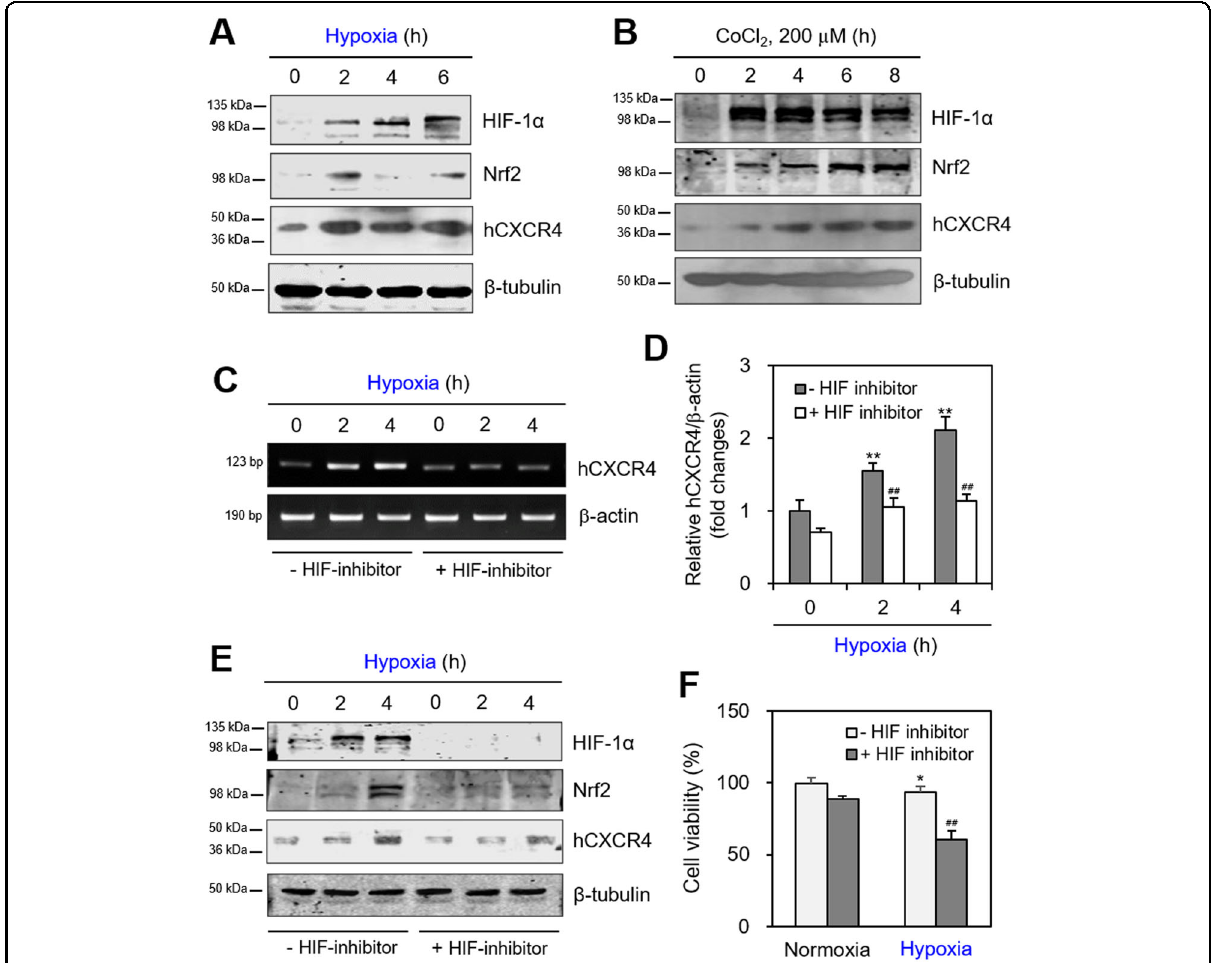
incubated in the presence or the absence of HIF inhibitor under hypoxic conditions. RNA was extracted by using Nucleozol. mRNA of hCXCR4 was measured by RT-PCR ( C ) or qPCR ( D ). Relative hCXCR4 transcripts were represented as bar graph ( D ). Cell lysates were prepared and the level of each protein was measured by western blot analysis ( E ). Cell viability was assessed by trypan blue exclusion assay and represented as bar graph ( F ). Each experiment was performed at least fi ve times. Data in bar graphs represented the means ± SD. * p < 0.05, ** p < 0.01; signi fi cantly different from control group under normoxic condition. # p < 0.05, ## p < 0.01; signi fi cantly different from HIF-1 α inhibitor-untreated group ( D , F